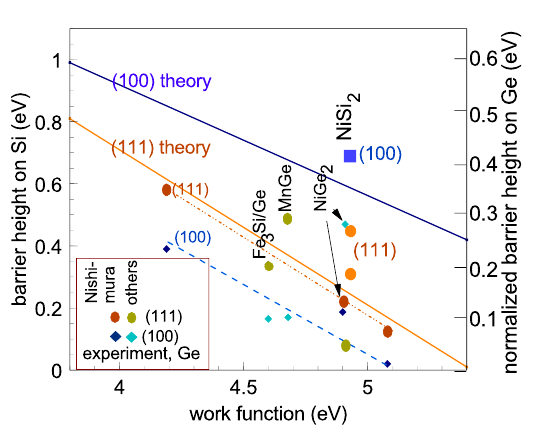
Figure 5. Normalised calculated barrier height values on Si and Ge from Figs 3 and 4, compared to experimental data for barrier heights from refs 12,22,30,32–36